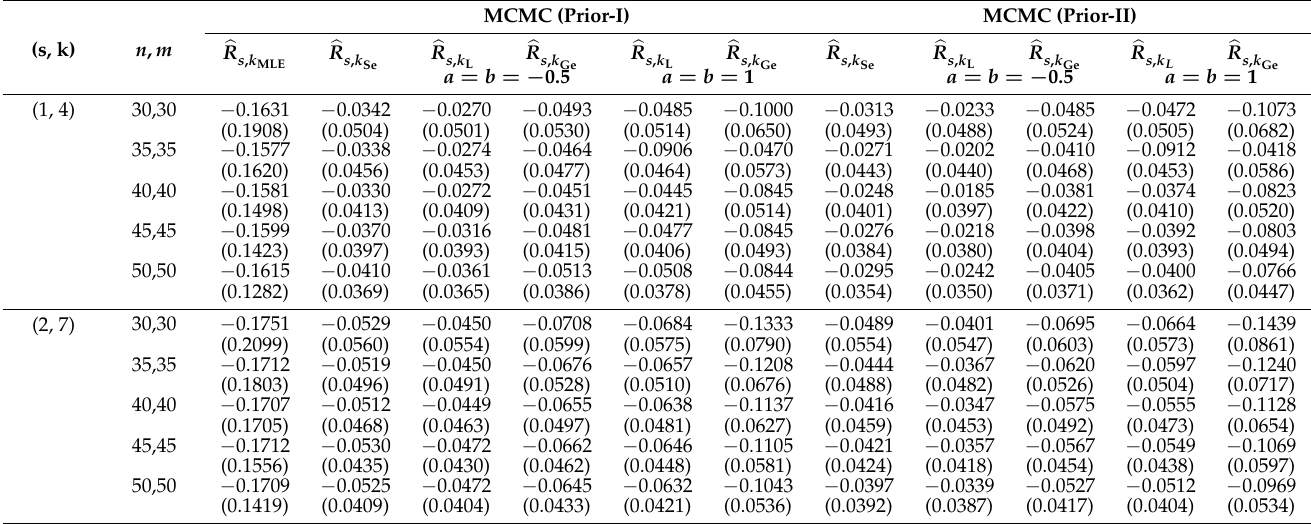
Table 2. The rBias and rMSE (in parentheses) for Case 1, ( α , λ 1 , β , λ 2 ) = ( 2, 2, 2, 3 ) and T = 1.